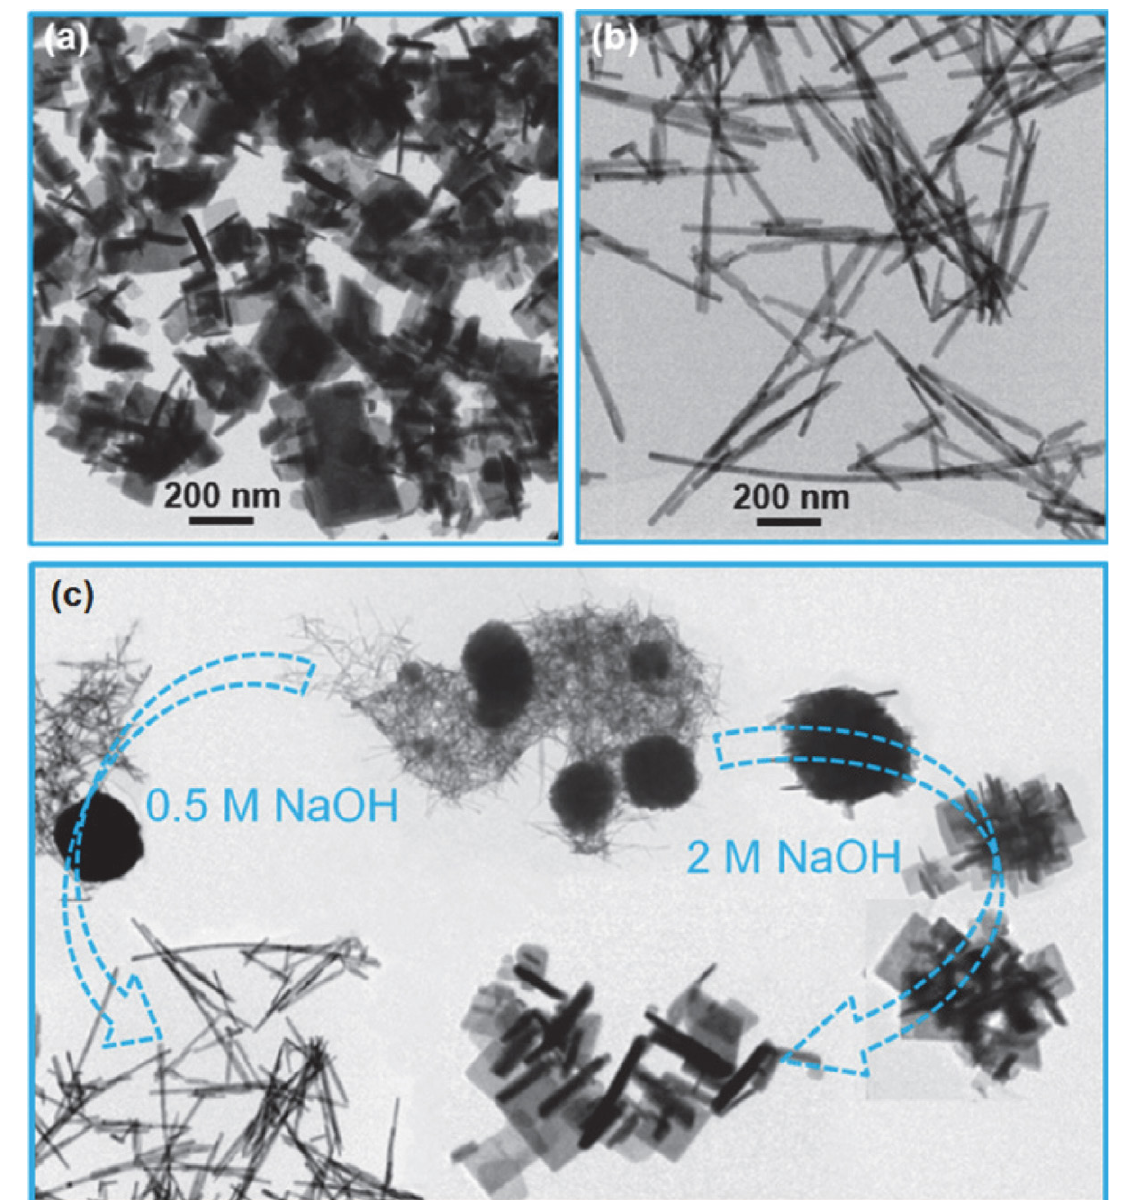
Figure 6. TEM images of bismuth-titanate NPLs (a) and NWs (b) synthesized with hydrothermal treatment of the precipitated Bi and Ti ions for 38 hours at 200 °C in the aqueous solution of NaOH with the concentration of 2 mol/L and 0.5 mol/L, respectively. (c) A schematic presentation of the morphology evolution during hydrothermal synthesis. Independently of the NaOH concentration, a mixture of NWs and globular nanocrystalline particles with a defected perovskite structure forms first. With temperature/time of the treatment in NaOH with a lower concentration, the per- ovskite aggregates dissolve, while the NWs grow. At a higher NaOH concentration, the NWs dissolve, while on the surfaces of the perovskite aggre- gates the NPLs grow epitaxially. ( (a) and (b) are reproduced from the publication by D. Makovec, N. Križaj, A. Meden, G. Dražić, H. Uršič, R. Kostan- jšek, M. Šala, S. Gyergyek, Nanoscale 2022, 14, 3537–3544, 52 (c) adapted from the publication by D. Makovec, N. Križaj, S. Gyergyek, CrystEngComm 2022, 24, 3972–398, with permission from The Royal Society of Chemistry. 52